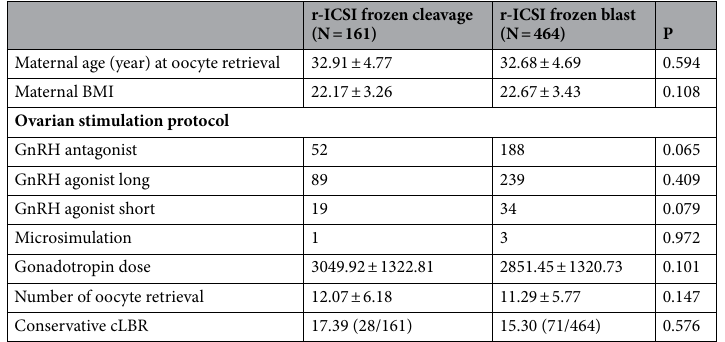
Maternal age (year) at oocyte